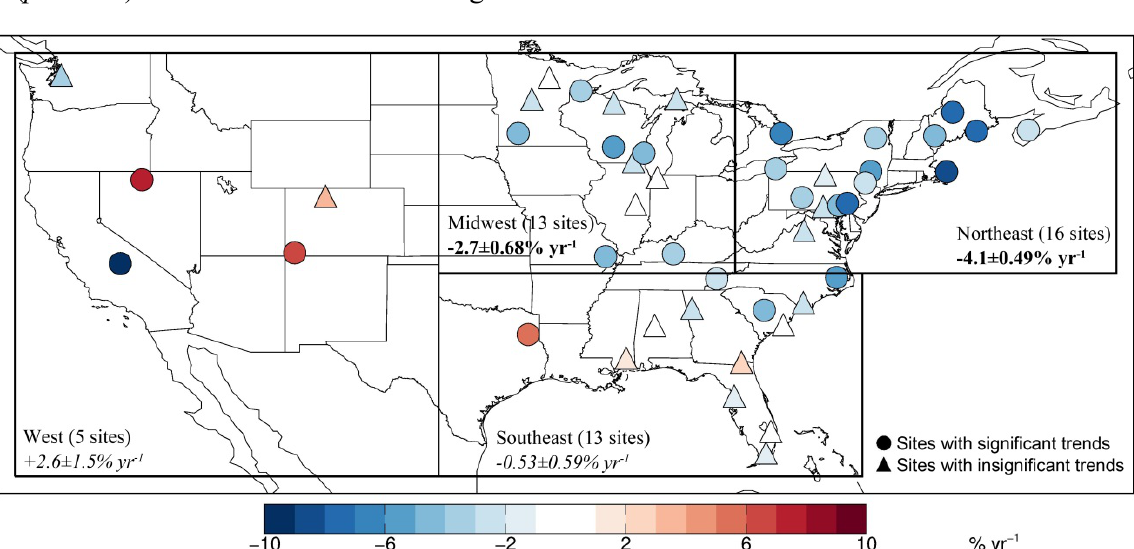
Figure 4. Trend in monthly VWM Hg concentrations at 47 MDN sites during